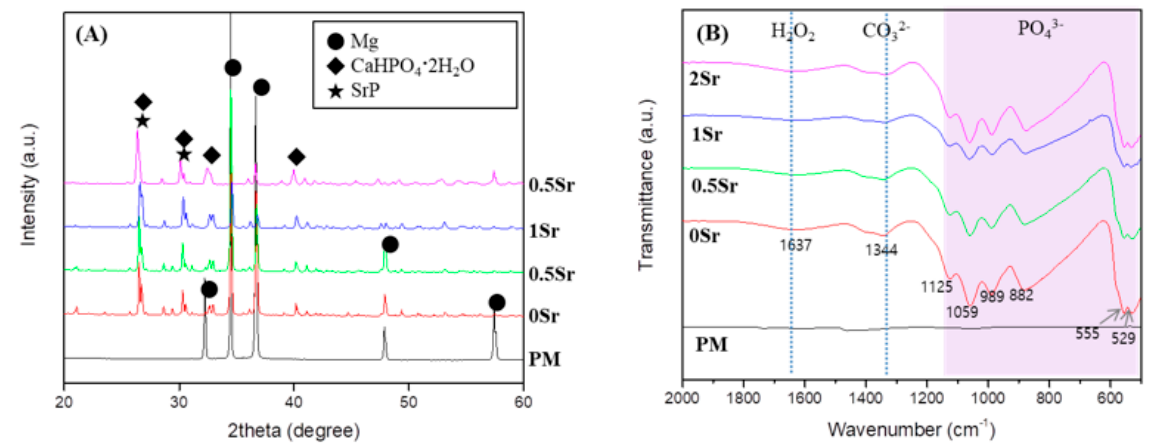
Figure 1. ( A ) XRD patterns; and ( B ) FT-IR spectrum of uncoated, Ca-P coated and Sr-doped Ca-P coated magnesium.